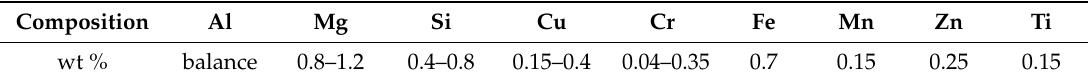
Table 3. The composition of aluminum 6061 alloy.